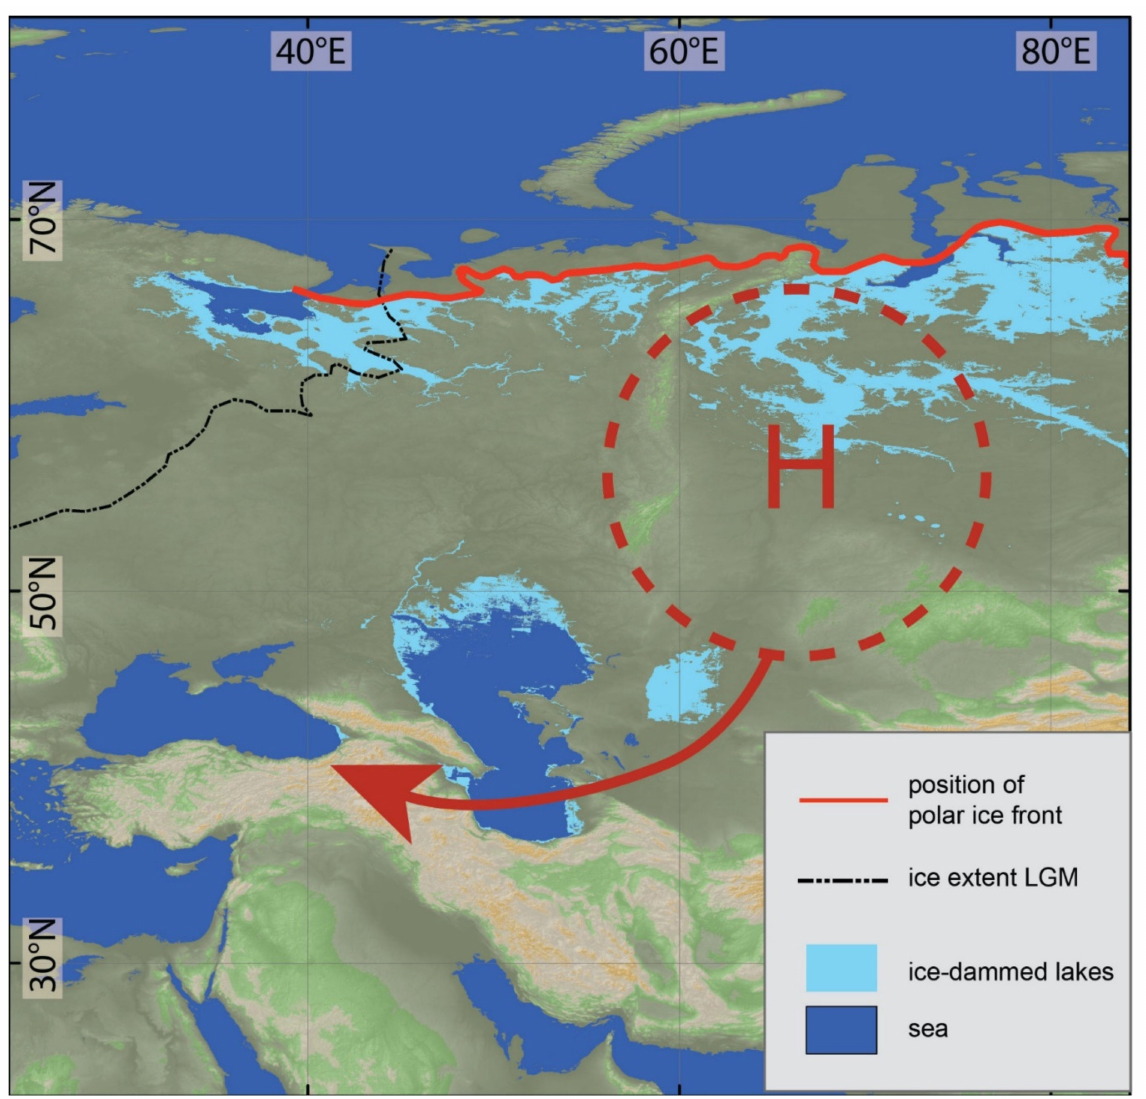
Figure 12. Reconstructed map of expanded water bodies between the Black Sea in the south and the White Sea in the north, modified from Mangerud et al. [60]. The age of 90 ka for this reconstruction by Mangerud et al. [60] is based on OSL dates on sediments of raised beaches, defining the large ice-dammed lakes, in this Figure calculated after Mangerud et al. [60]. This dating implies the early last glacial advance of Kara Sea ice onto the land. This chronology is under debate. Here, this reconstruction is combined with the fact that the Polar Front and, as a consequence, the Siberian High were pushed much to the south which activated northeasterly airflow to bring moisture to the Caucasian and Kaçkar Mountains from the